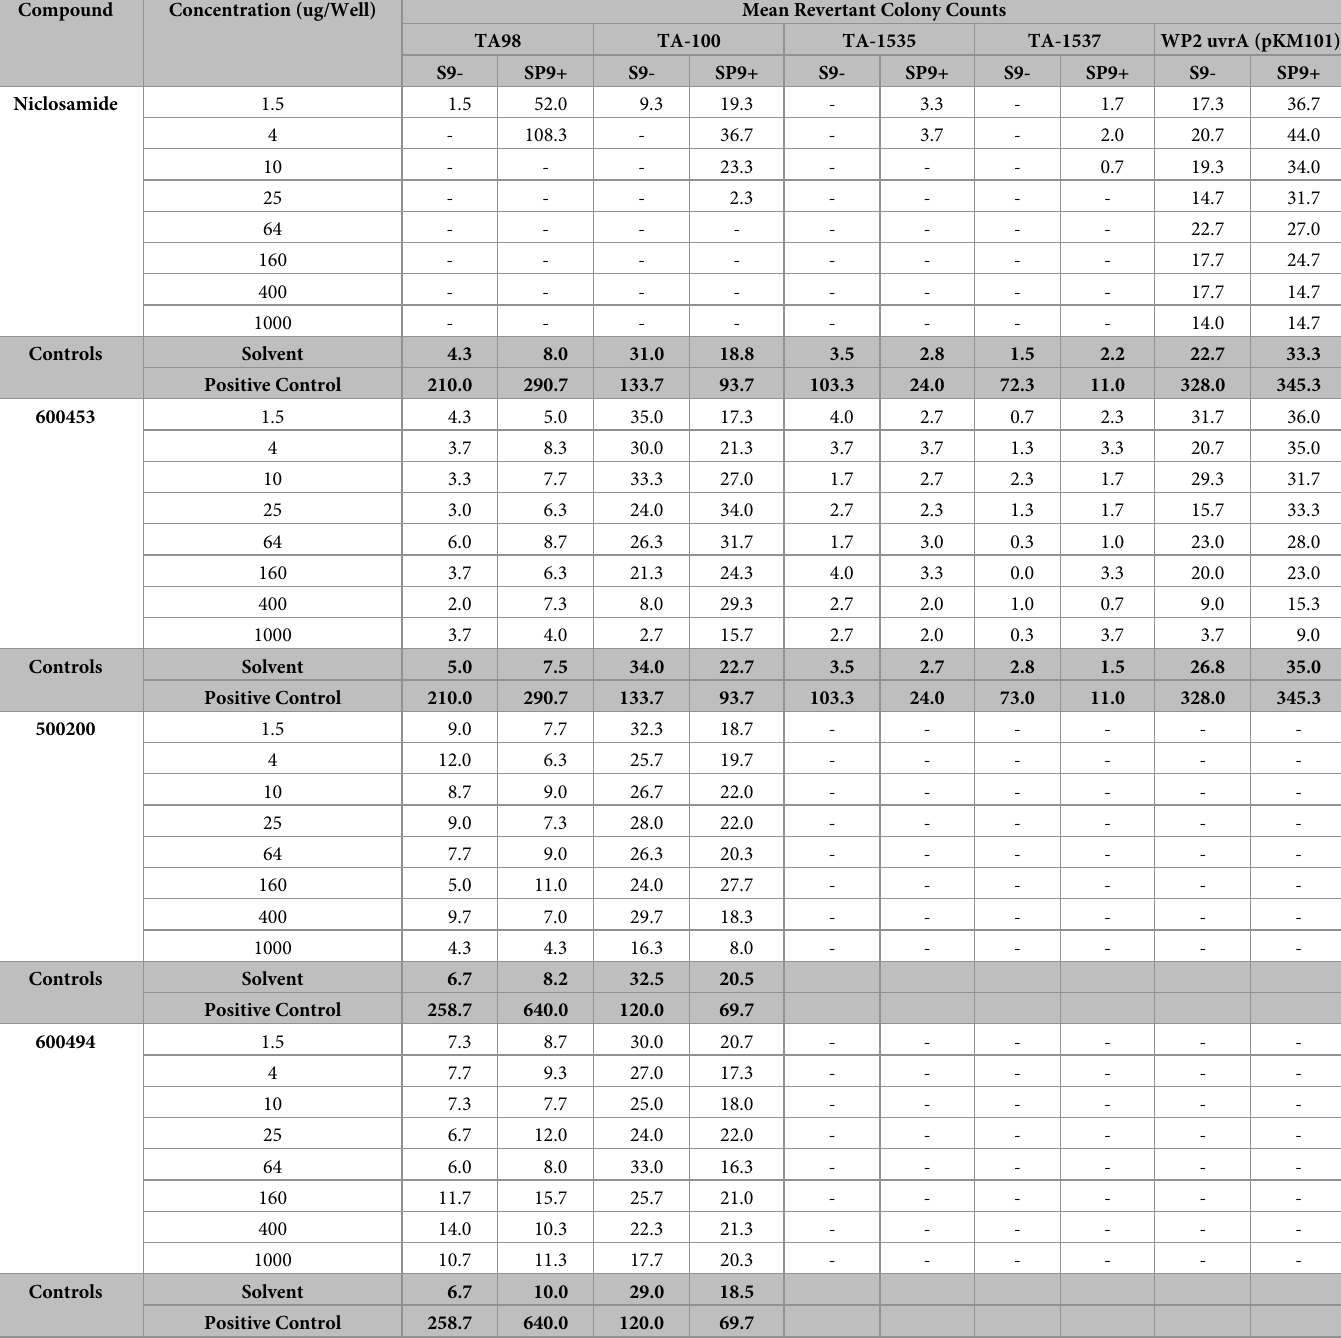
Table 4. Niclosamide analogs attenuate hepatic steatosis in high fat diet fed mice. 20-week old HFD-fed mice were delivered vehicle or compound daily at 10mg/kg by I.P for 12 days. Body weight measurements and scoring of greasy coat phenotype were performed prior to and following treatment. Histological analysis of H&E stained liver sections were analyzed and the % of steatosis and steatosis score are reported. Compound Concentration (ug/Well)